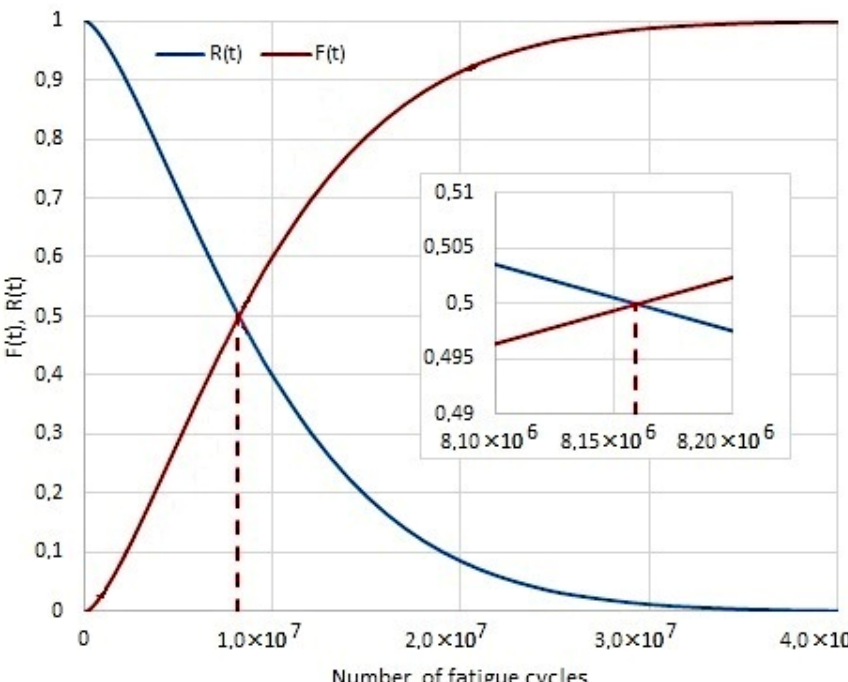
Figure 9. The course R(t) and F(t) for the shaft after rolling.